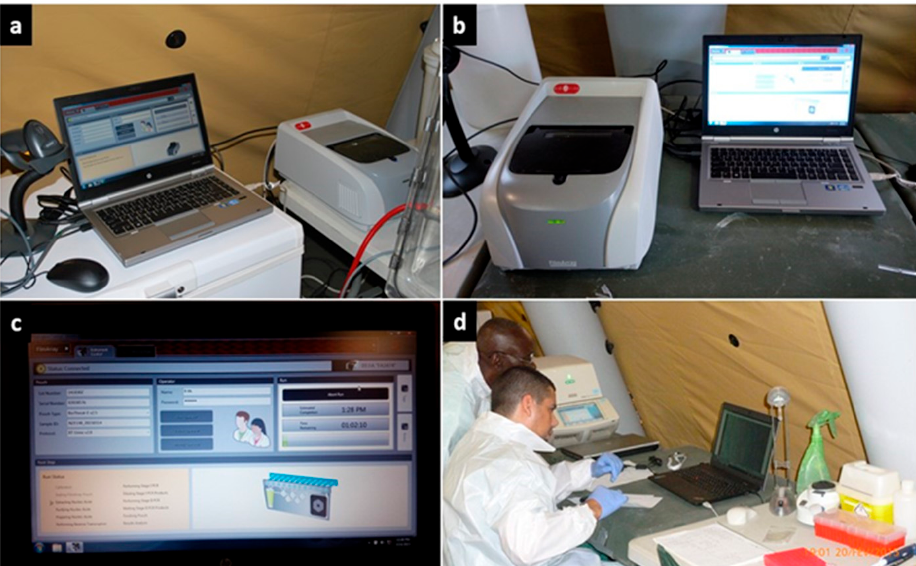
Figure 6. The BioFire FilmArray (BFA) system. ( a ) The BFA reader was installed inside the laboratory tent, ( b ) but outside the glovebox. ( c ) The BFA instrument was installed and connected to a computer with the adequate software-hardware. ( d ) The results generated by the trainees were transferred on a stand-alone computer to be reviewed and discussed with the staff.